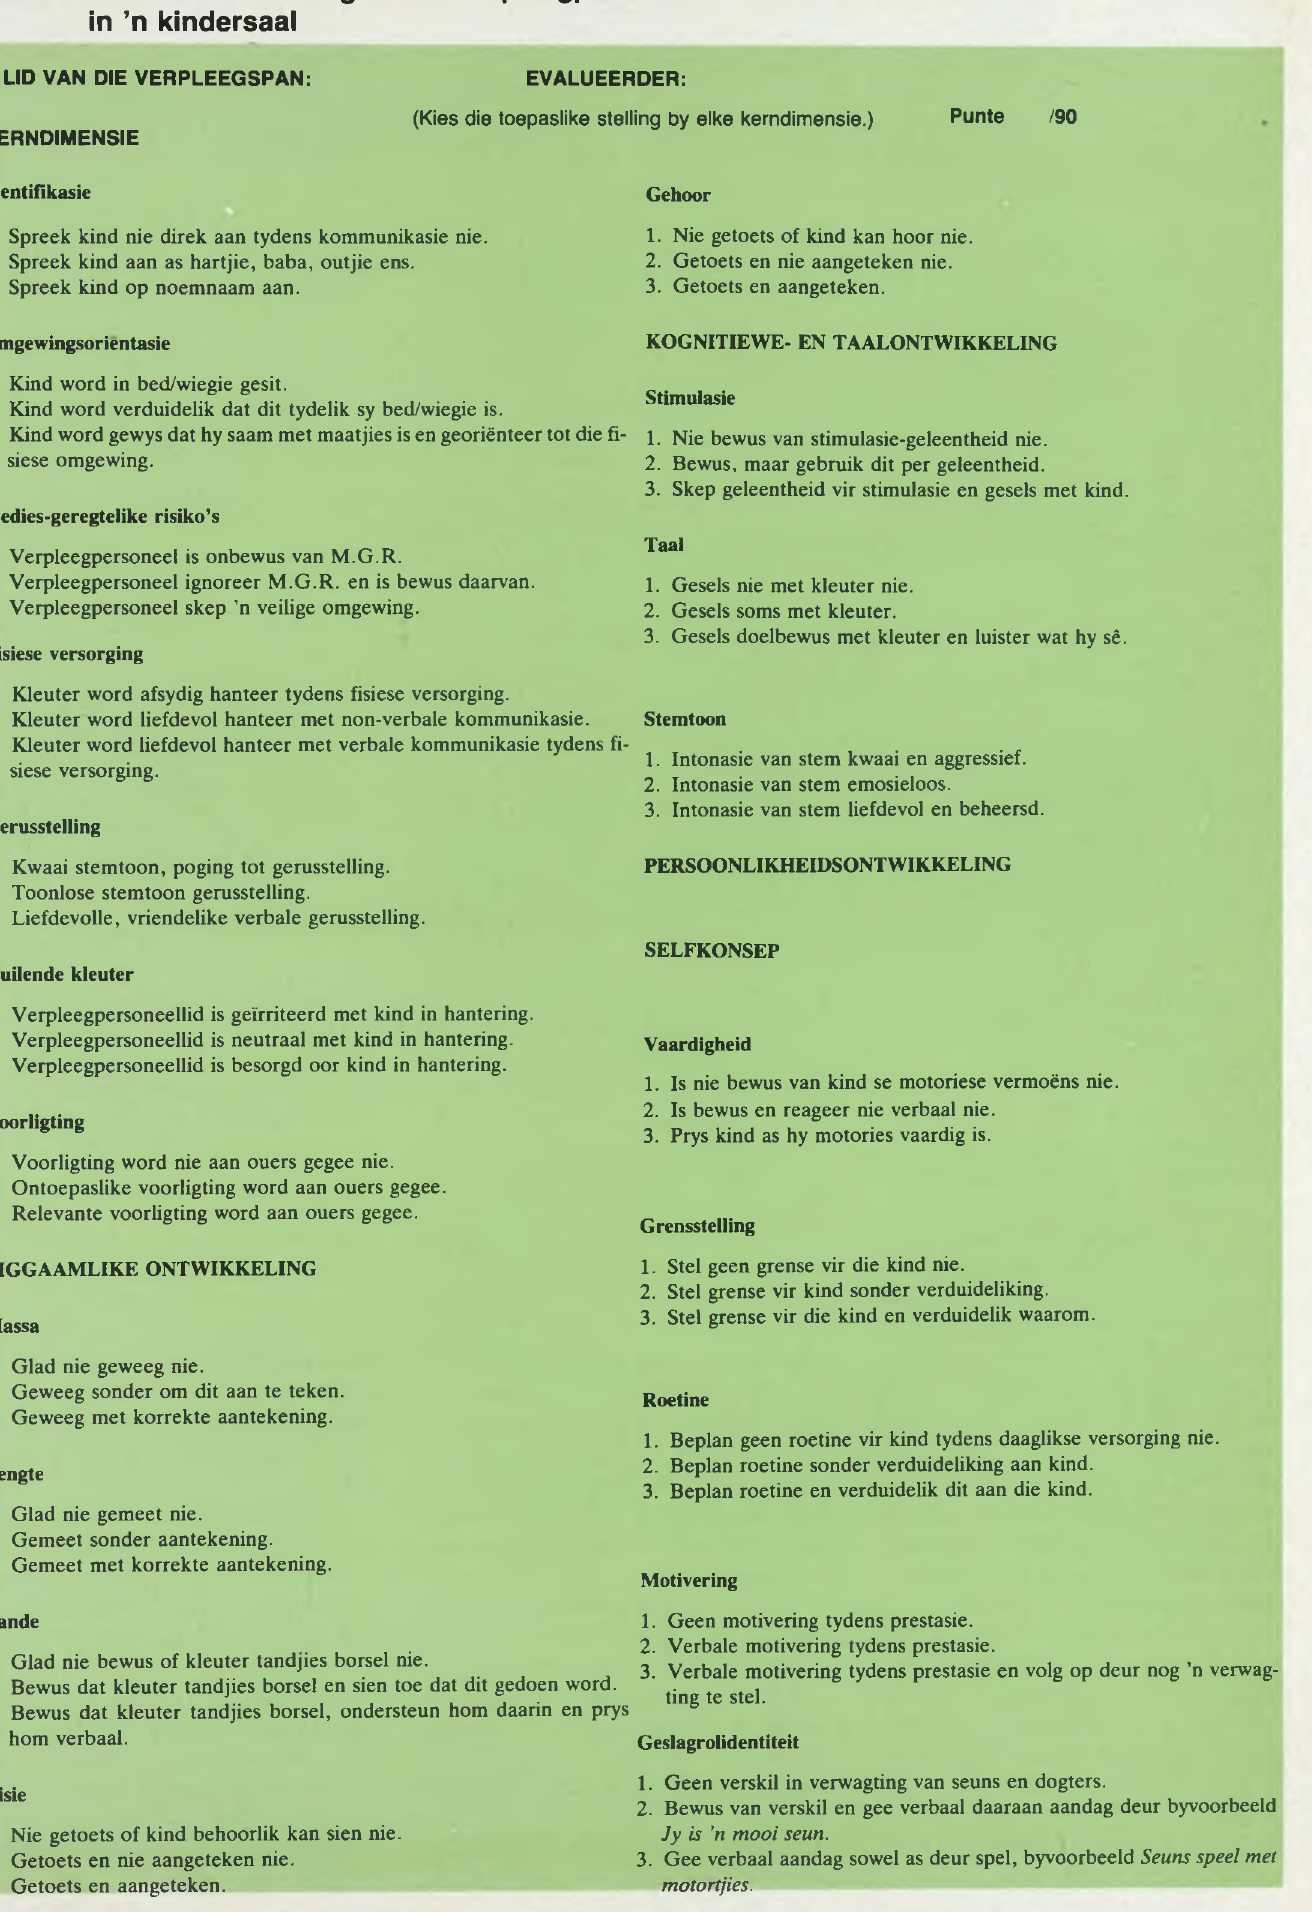
Tabel 1. Skaal vir evaiuering vir die verpleegpersoneel se interaksie met kleuters in ’n